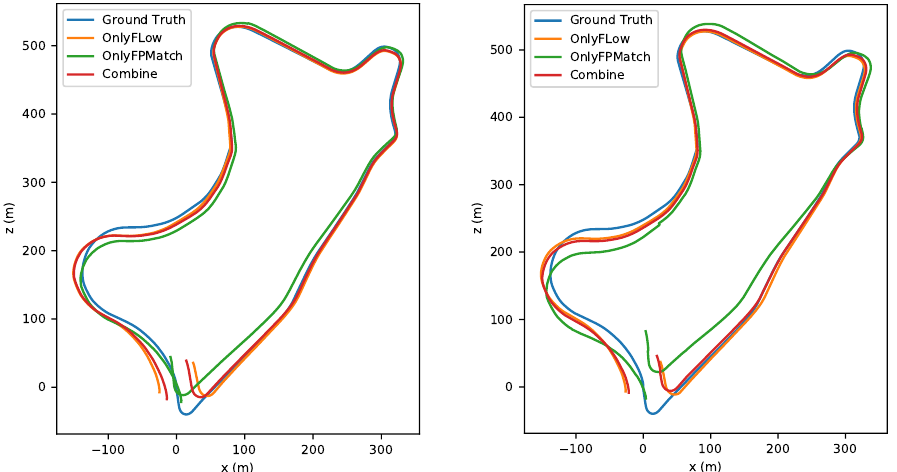
Figure 7. The left image shows the estimated trajectories in a normal-motion scene (stride = 1). The right image shows a small-amplitude-motion scene (stride = 2) of sequence 09 in the KITTI dataset